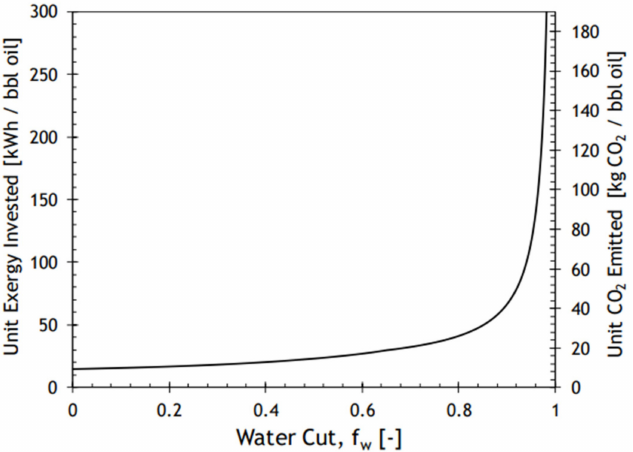
Figure 1. Release of CO 2 depending on water cut